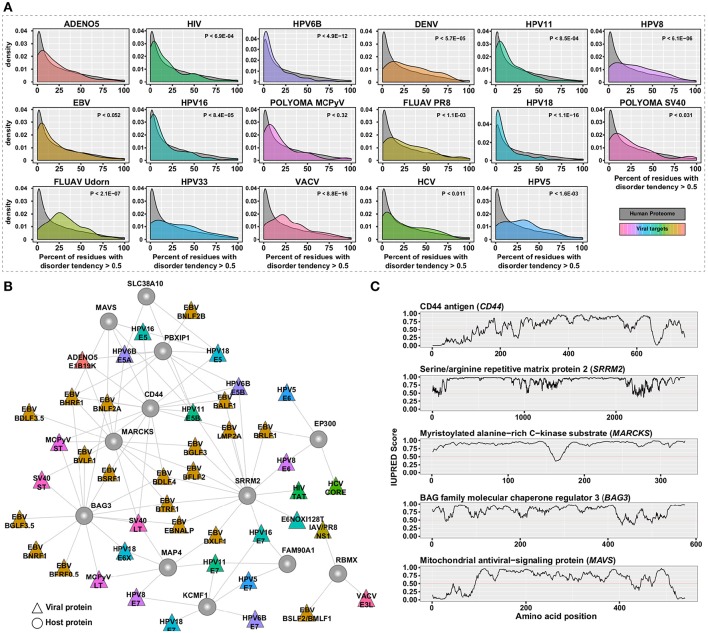
Protein disorder analysis. (A) Density plot of the distribution of host proteins for each virus with percent of residues with disorder tendency greater than 0.5 as predicted by the IUPred software as compared to the human proteome. (B) Sub-network of hvPPI with the highly targeted and highly-disordered proteins. (C) Line plots showing the IUPred Score (a measure of the disordered region) for the five selected host proteins from the sub-network. A IUPred score of >0.5 is considered disordered.